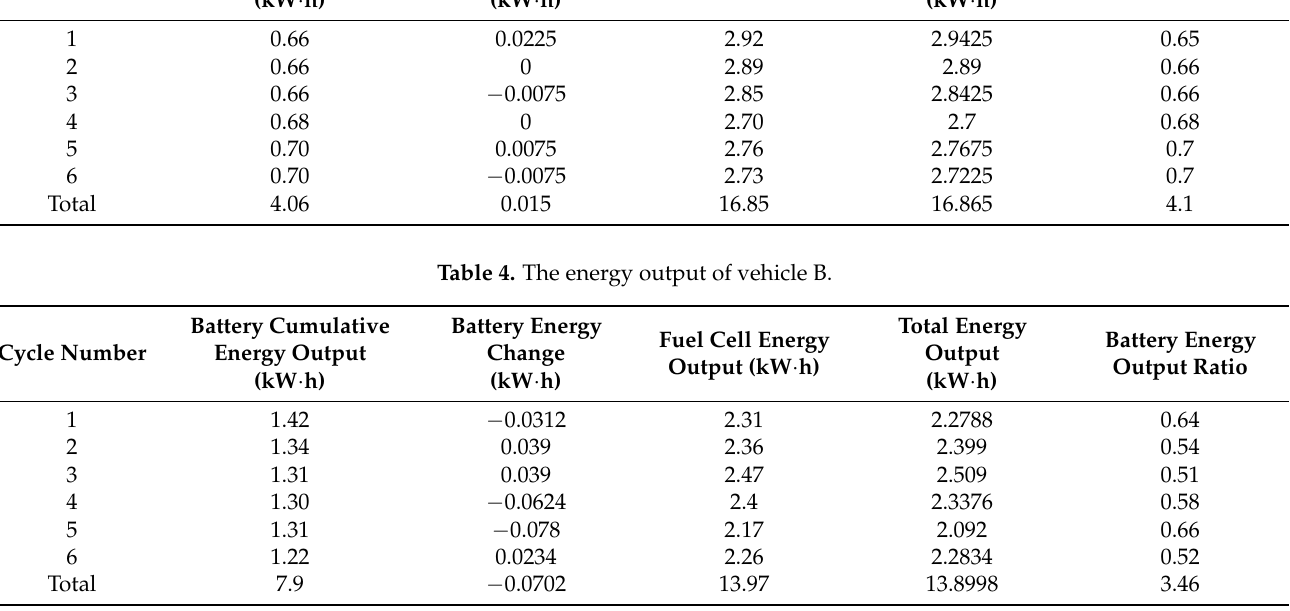
Figure 7. The change of battery output power after the reactor’s power rises from 30 kW to 40 kW: ( a ) Vehicle A; ( b ) Vehicle B.